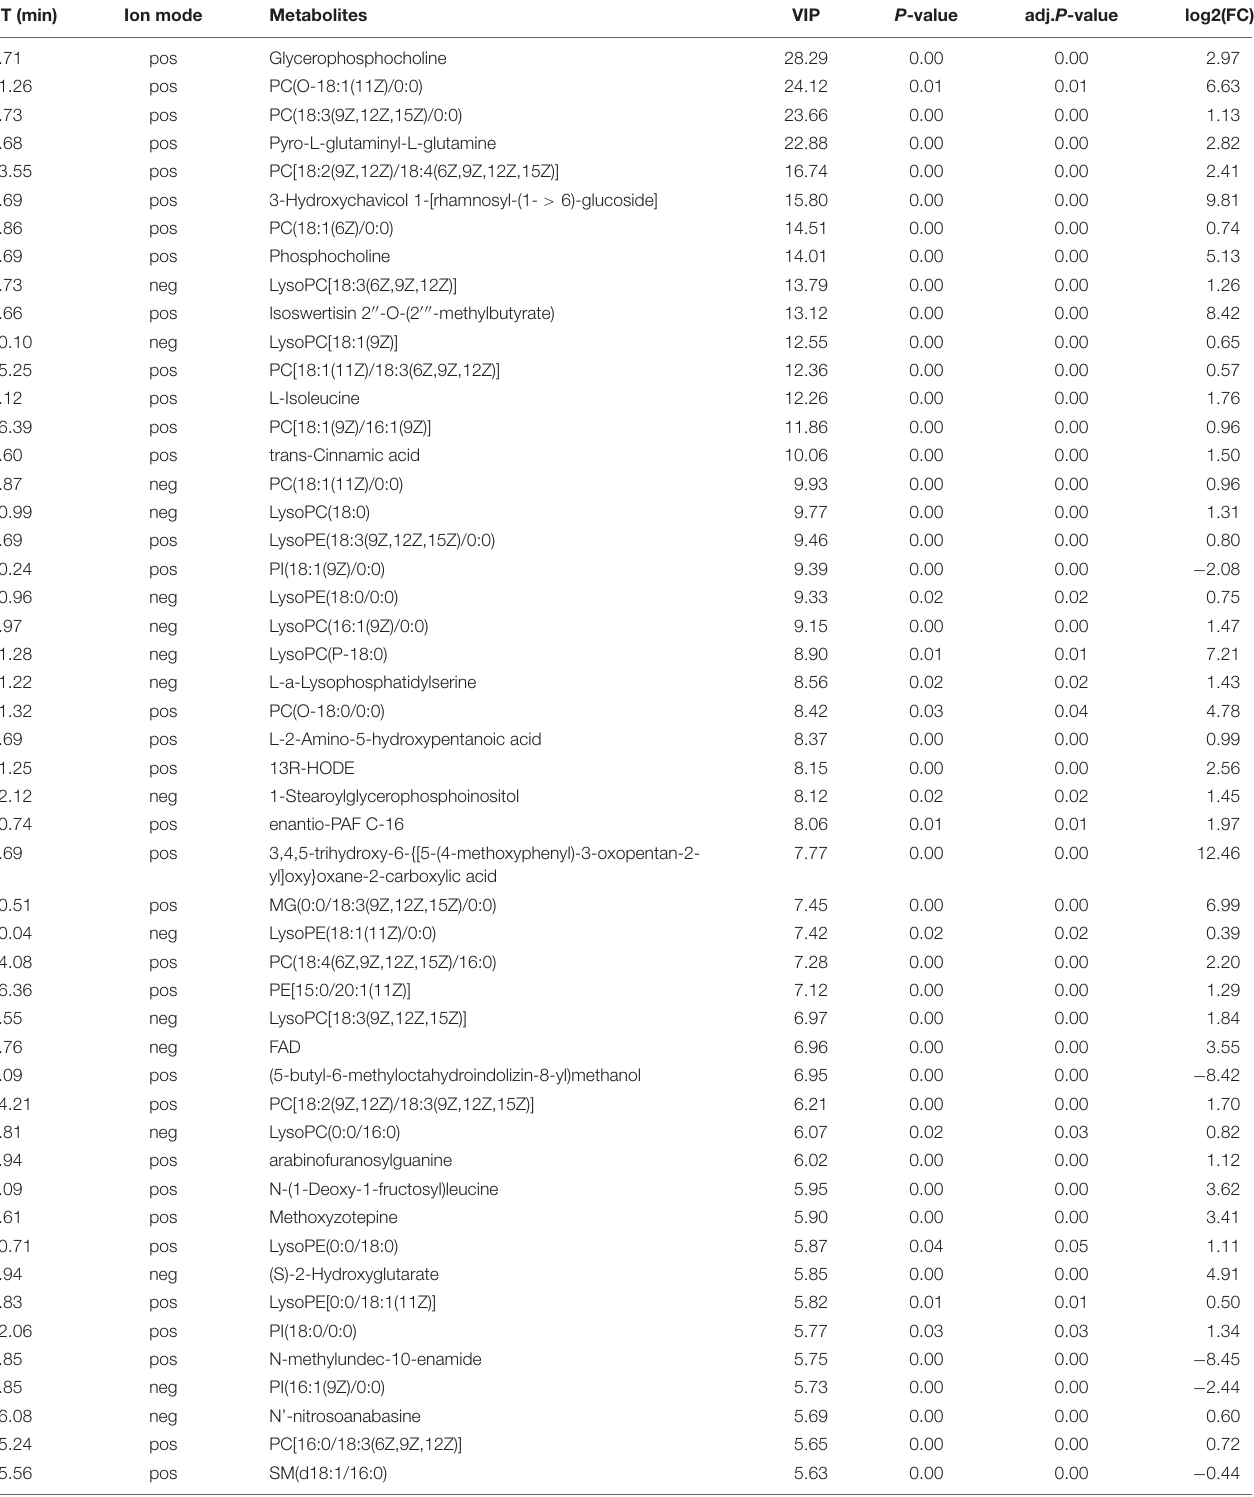
TABLE 1 | Top 50 metabolites that were qualitatively significantly different in NLQS compared with those in VQS of honeybee Apis